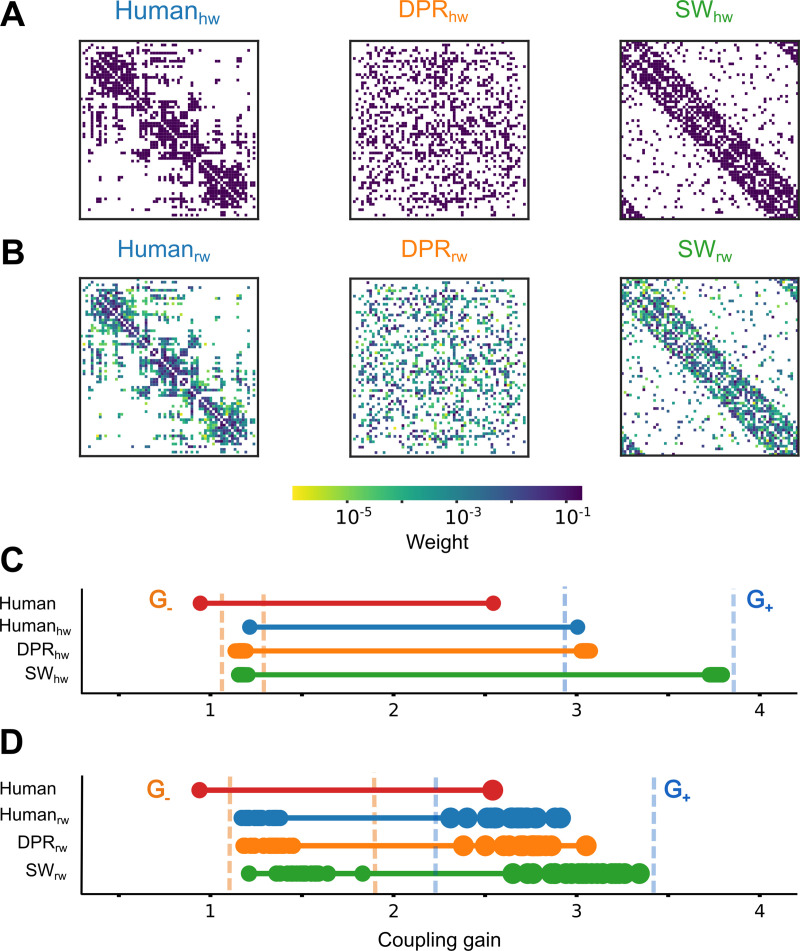
The human cortical connectome requires a lower coupling gain to display ignition than surrogate models.(A) One example of the unweighted surrogate connectomes (uSCs) matrices, in which connections were normalized to make reliable comparisons with Human (each purple entry was set to 1.332x10-2). The DPRhw networks disrupt the connectivity pattern but preserve the degree distribution. The SWhw networks display a small-worldness value close to the Human. (B) One example of the weighted surrogate connectomes (wSCs) matrices. The colour bar shows the connection weights in a log-scale. (C-D) Bistable range of the Human compared to either uSCs (C) or wSCs (D), highlighting the bifurcation G- (left) and G+ (right) points. The orange dashes (blue dashes) show the range of values for G- (G+) in surrogate connectomes.